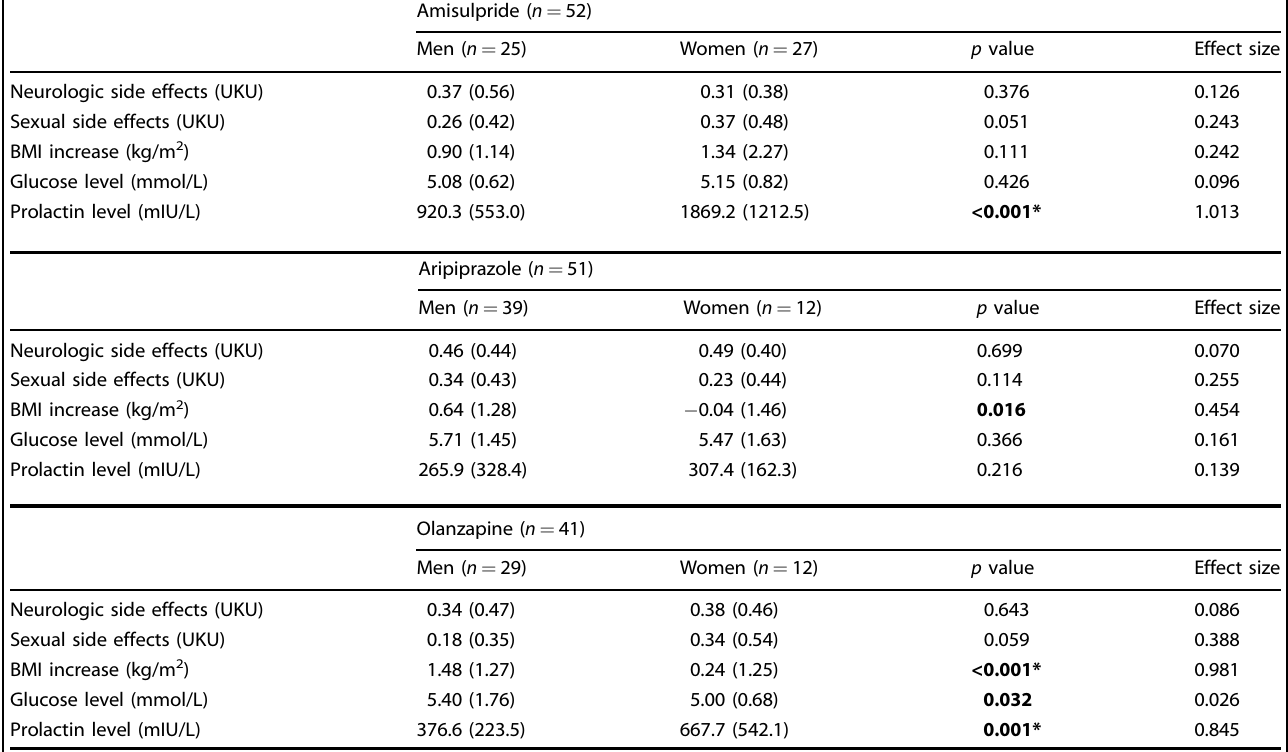
Table 3. Comparison between men and women for mean side